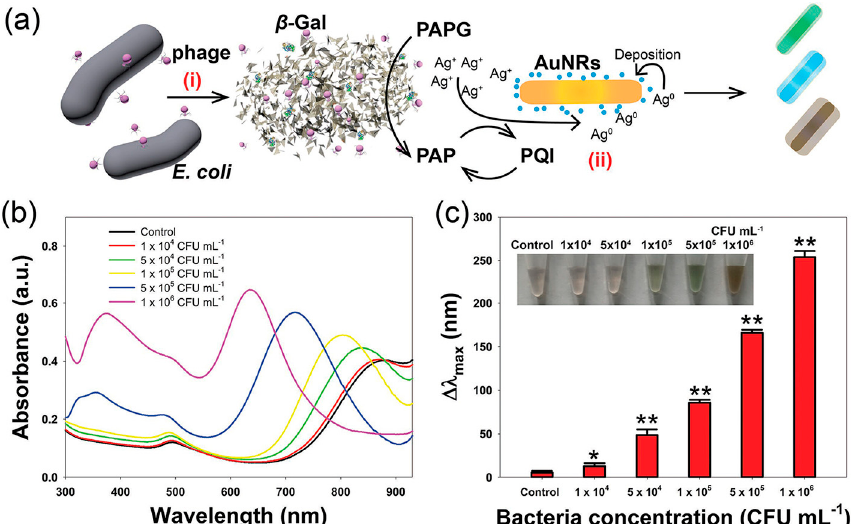
Figure 1. ( a ) Schematic illustration of the enzyme-induced metallization colorimetric assay for the detection of E. coli cells; ( b ) UV–vis absorption spectra of the colorimetric assay toward various E. coli concentrations; ( c ) The blue shift in the longitudinal LSPR peak toward various E. coli concentrations (inset: the corresponding photographs). Reprinted with permission from [78]. Copyright (2016) Wiley-VCH Verlag GmbH and Co. KGaA, Weinheim.